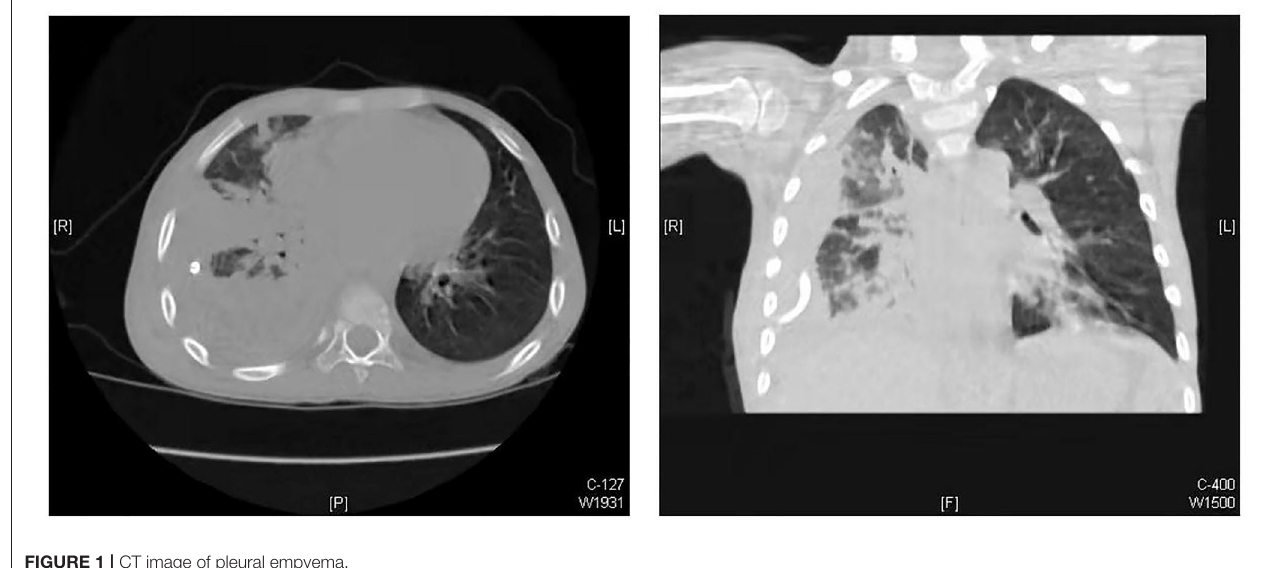
FIGURE 1 | CT image of pleural empyema.